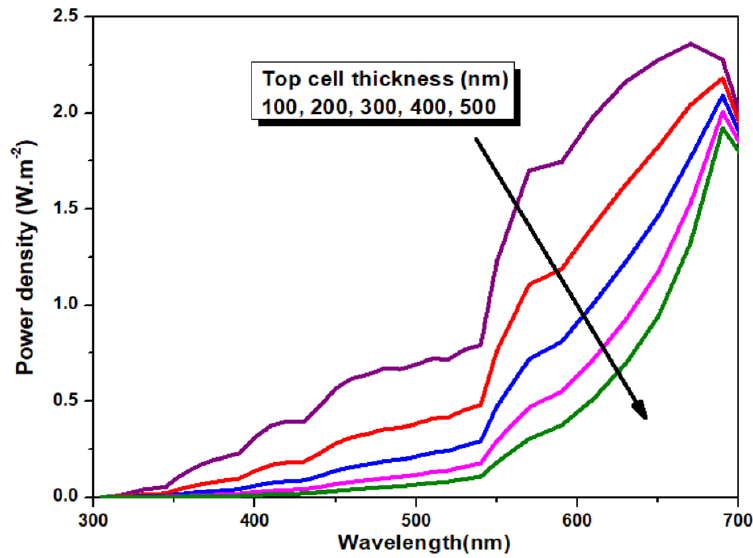
Figure 11. Transmitted spectrum by the top sub-cell for different thicknesses of the absorber of the top sub-cell.